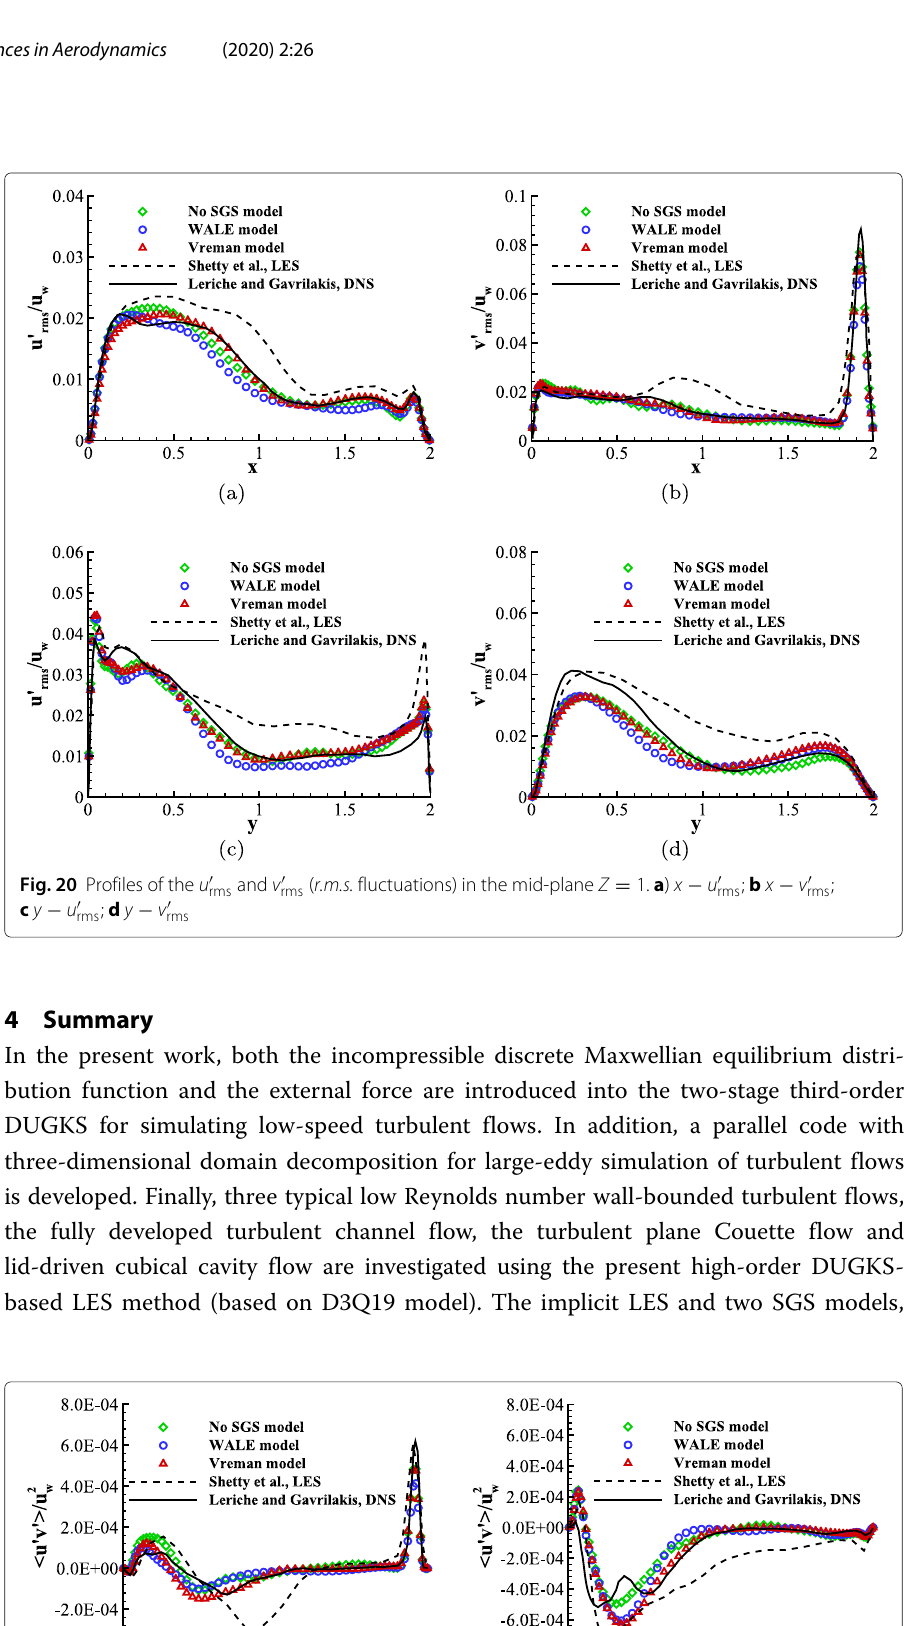
# $ u (cid:11) v (cid:11) along the central lines in the mid-plane Z = 1. a the central line ( x ,1,1 ) ,